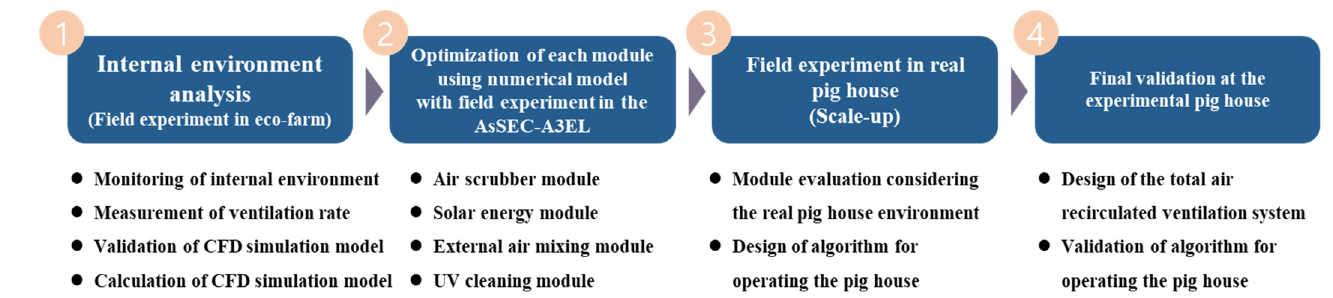
Figure 2. Flowchart of development of the air-recirculated ventilation system.